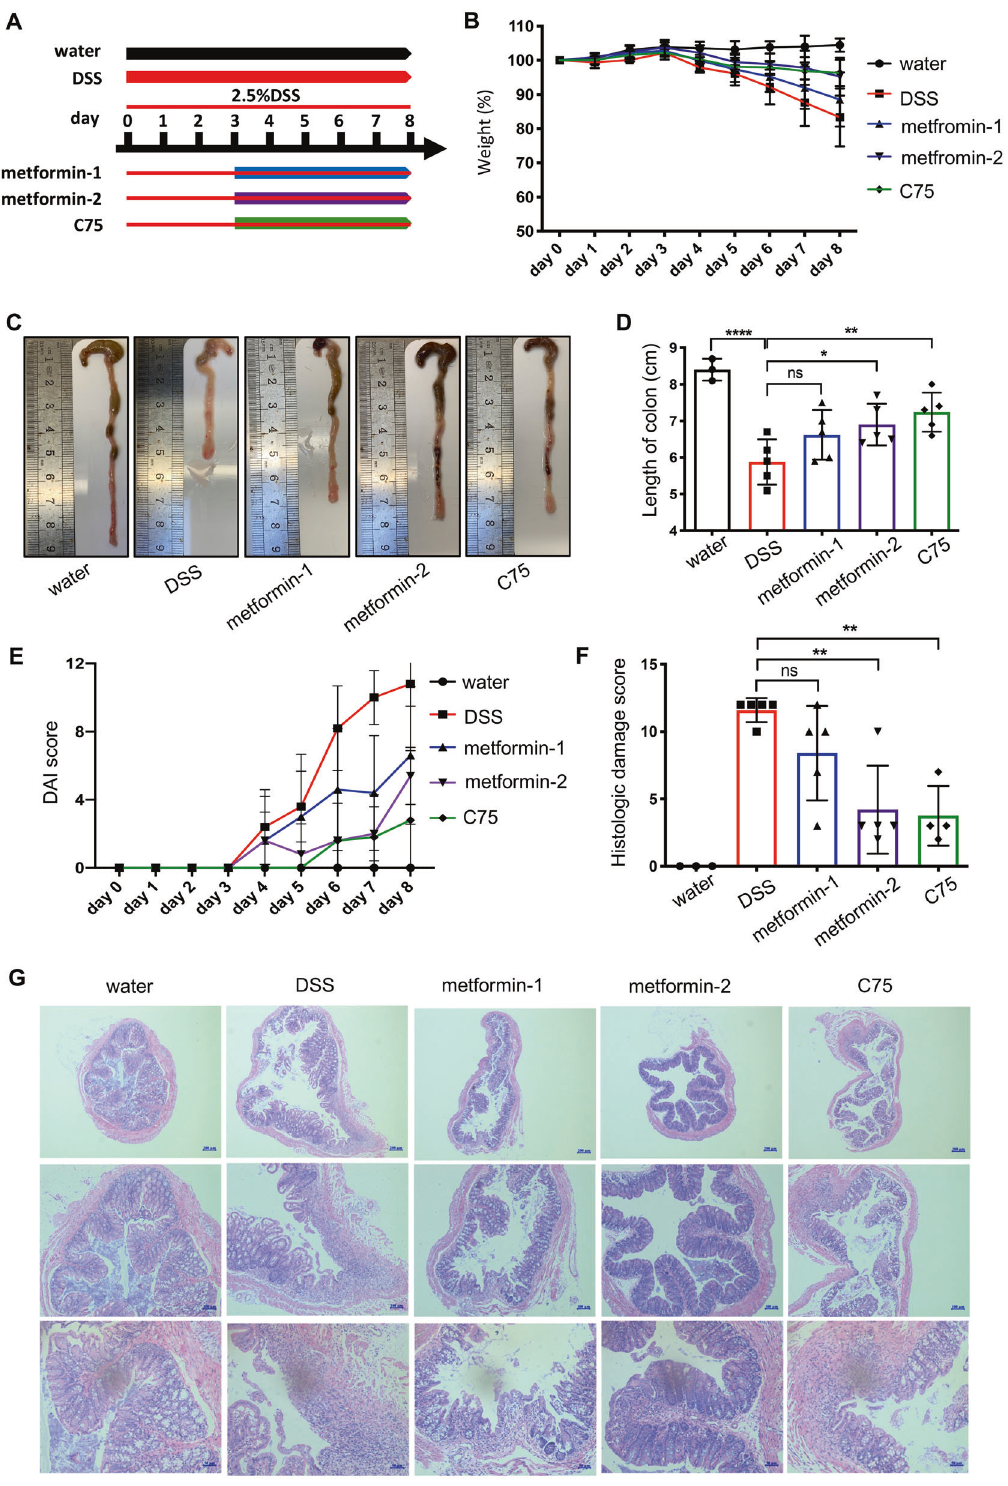
Fig. 7 The therapeutic effect of metformin and C75 on dextran sulfate sodium (DSS)-induced colitis mice. A An overview of animal experiments ( fi ve mice in each group). B Weight loss was measured each day during the whole experiment. C , D After mice were sacri fi ced, the length of colons was recorded and quanti fi ed. E Disease activity index (DAI) was calculated according to weight loss and characteristics of feces. F , G Hematoxylin and eosin (H&E) staining was utilized to evaluate colon damages. The extent of damages was quanti fi ed by a score ranging from 0 to 12 ( F ). Representative images of H&E staining ( G ). metformin-1: 100 mg/kg; metformin-2: 200 mg/kg; C75: 5 mg/kg. Data were represented as means ± SD. * p < 0.05, ** p < 0.01, *** p < 0.001, **** p < 0.0001, ANOVA.